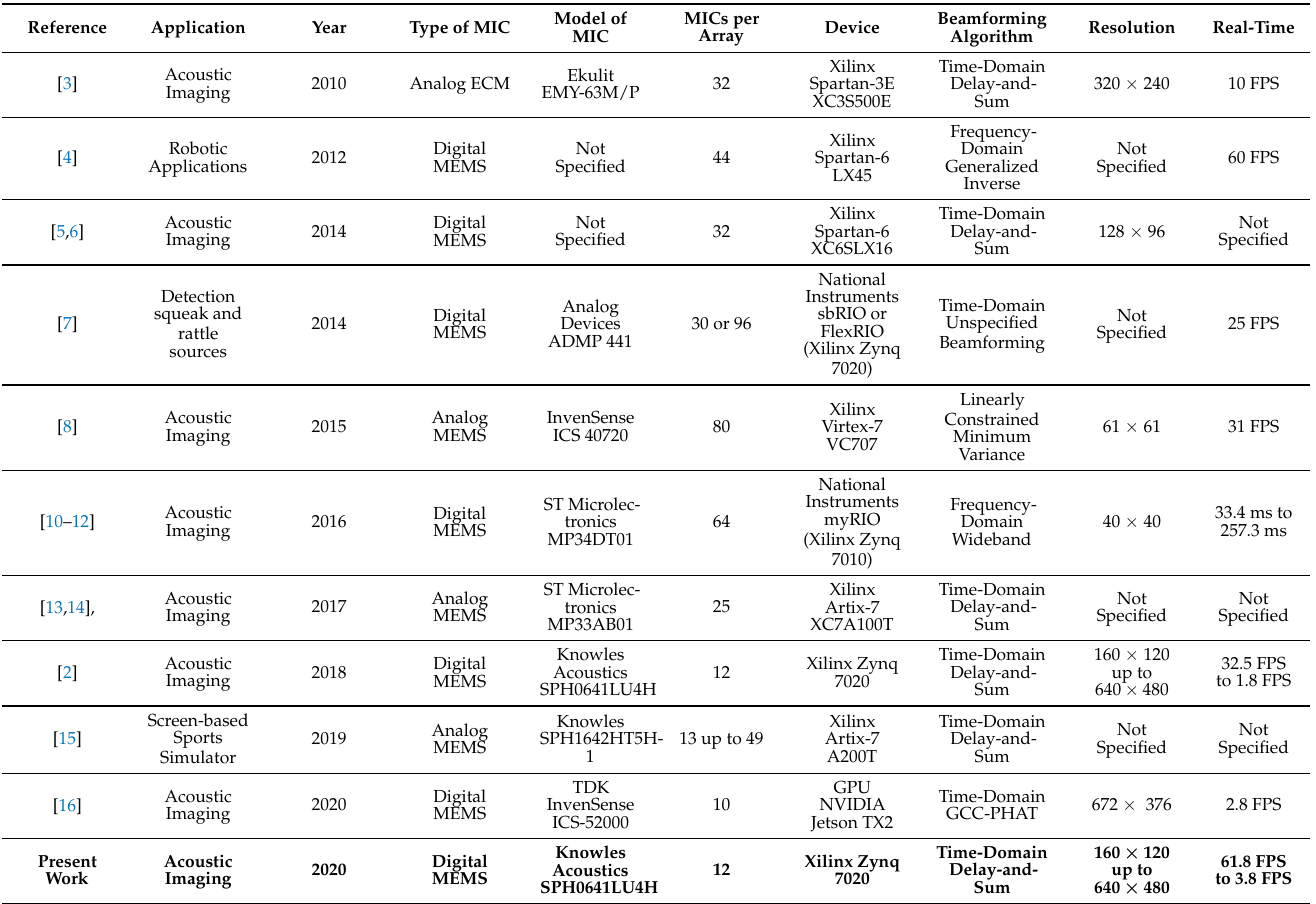
Table 1. Summary of architectures for acoustic imaging. The contributions described in this thesis are marked in